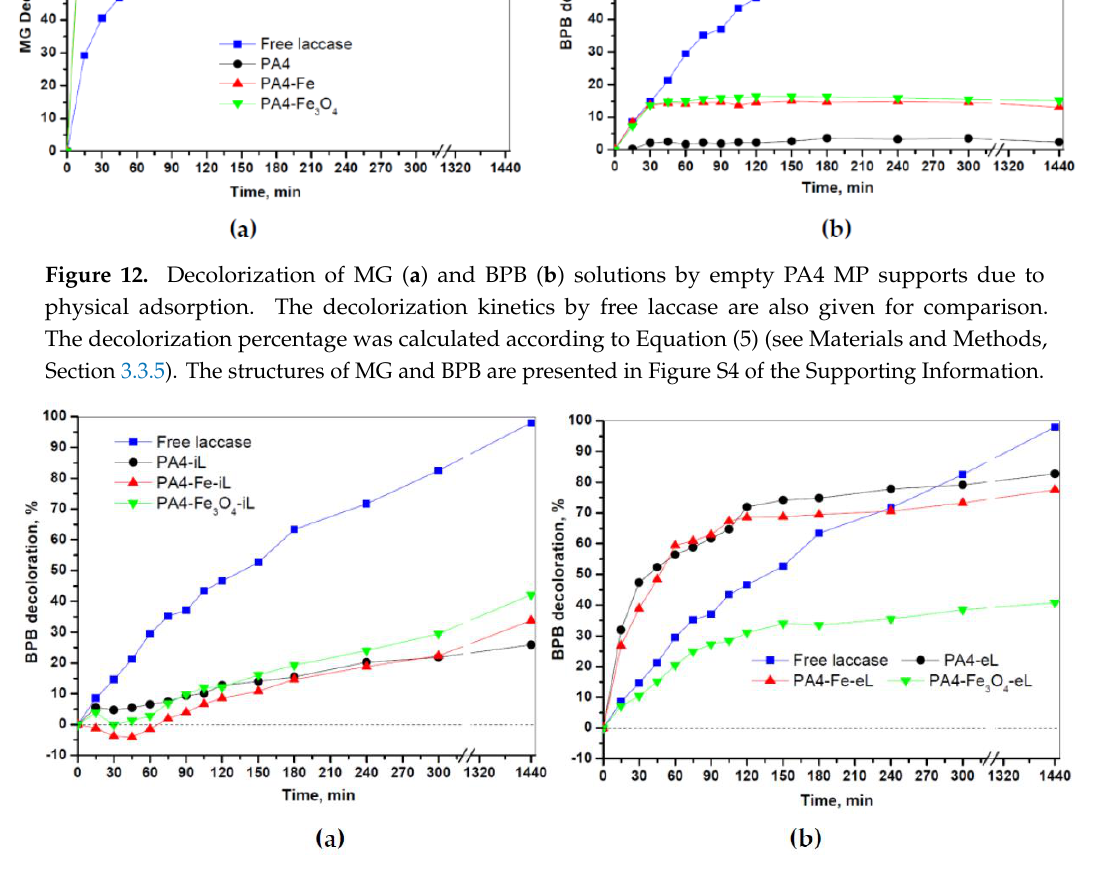
Figure 13. Resultant decolorization (RD) of BPB solution by: ( a ) PA4@iL samples and ( b ) PA4@eL samples. RD is obtained by subtracting the adsorption-caused decolorization (Figure 13) from the total decolorization (Figure 12).